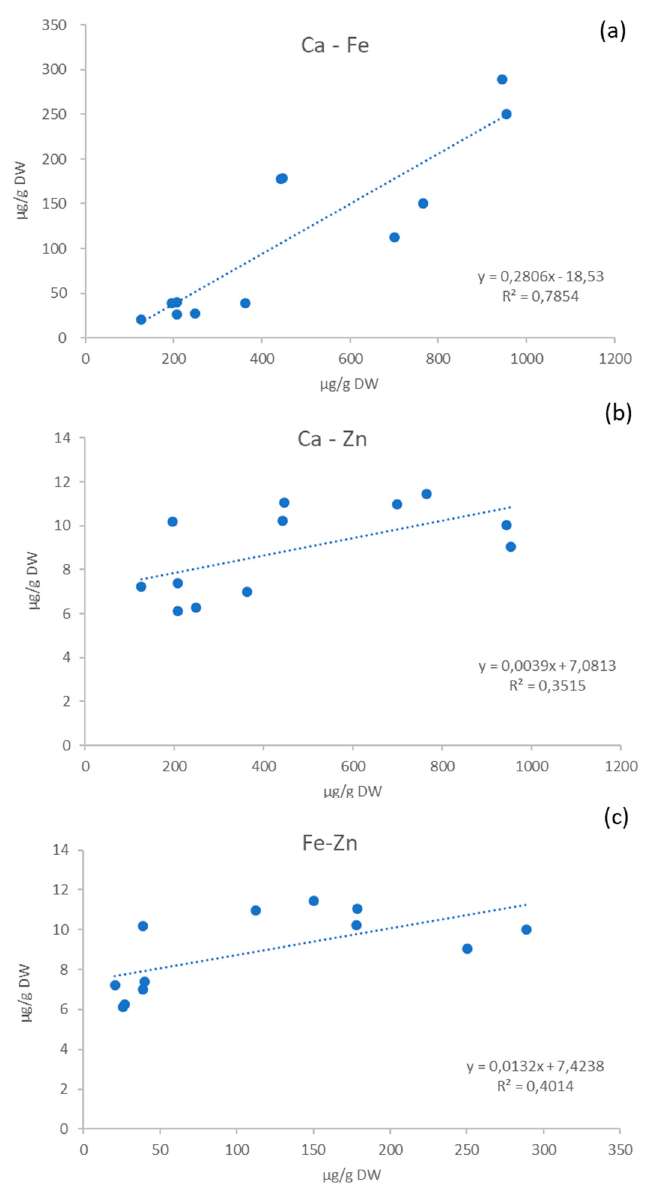
Figure 2. Correlations between calcium and iron ( a ), calcium and zinc ( b ) and iron and zinc ( c ) concentrations (µg/g DW) for the six Andean genotypes.